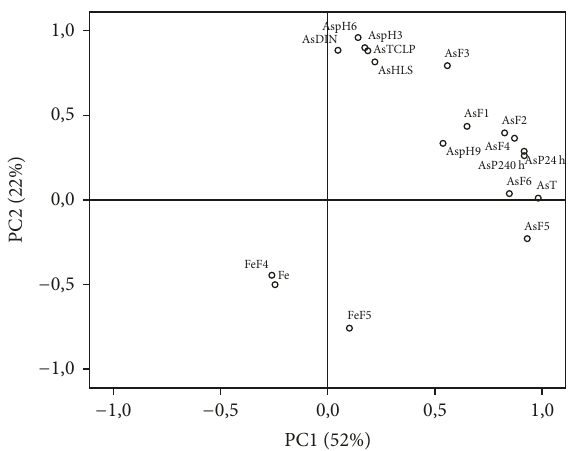
Figure 6: Principal component analysis for the evaluation of factors affecting As